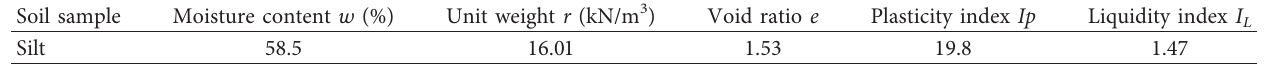
Table 1: Basic physical and mechanical indexes of